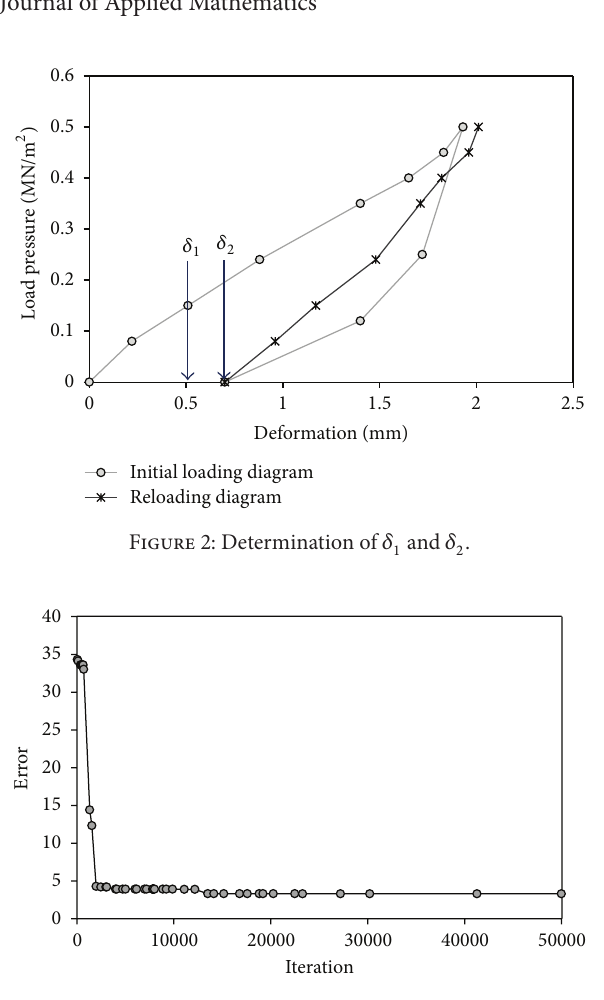
Figure 3: Error in each iteration of the HS algorithm.